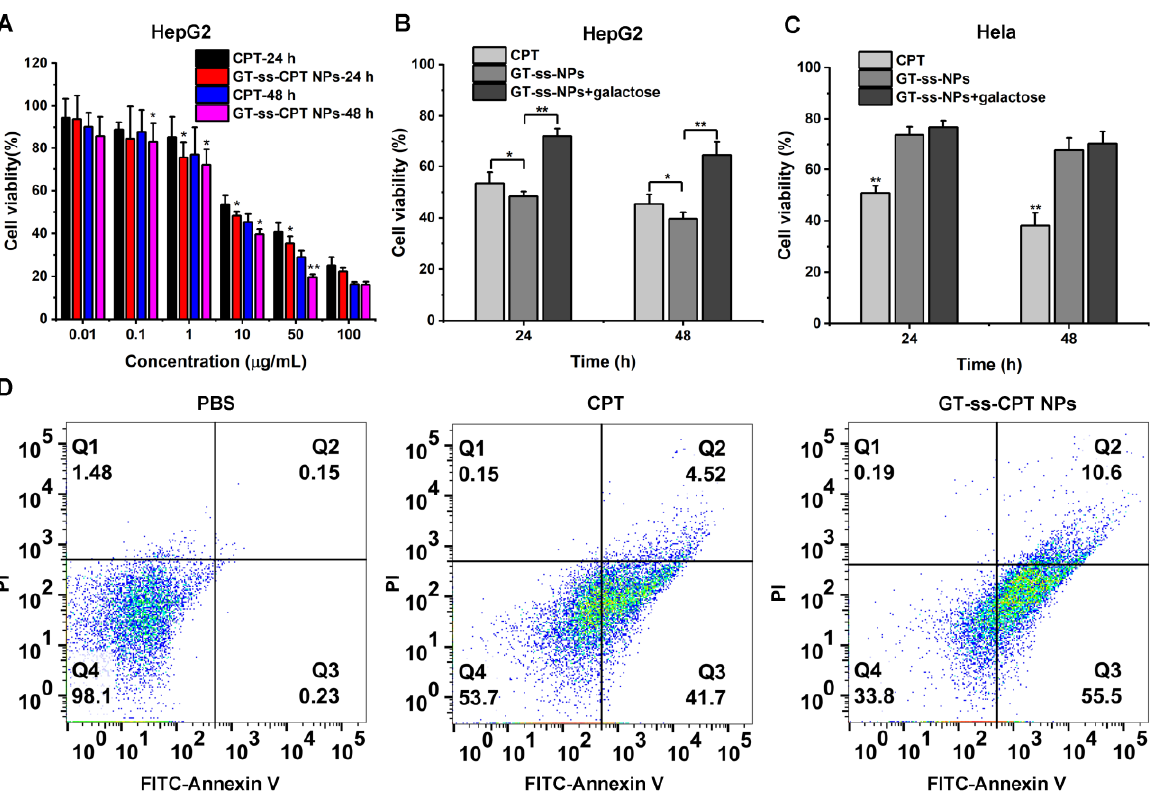
Figure 4. In vitro anticancer activity. ( A ) The cytotoxicity of GT-ss-CPT NPs and free CPT toward HepG2 cells at various concentrations of CPT for 24 h and 48 h incubation ( n = 6). * p < 0.05, ** p < 0.01 (ANOVA test). Cell viability of ( B ) HepG2 cells and ( C ) Hela cells incubated with GT-ss-CPT NPs and free CPT for 24 h and 48 h in the presence or absence of galactose (10 mM). ( D ) HepG2 cell apoptosis rate after incubation with PBS, free CPT, and GT- ss -CPT NPs for 24 h. Q1 – Q4 quadrants represents necrotic cells, late apoptotic cells, early apoptotic cells, and living cells, respectively.